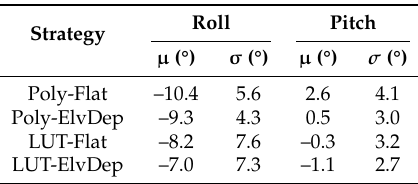
Table 1. Mean and standard deviation attitude estimation performance of the GPS signal strength based attitude